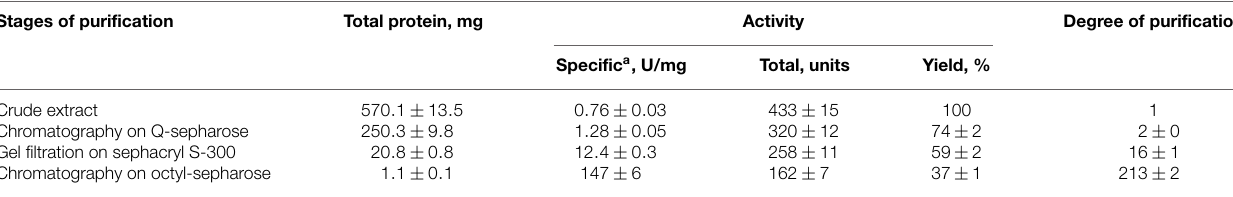
TABLE 2 | The purification of EnoCa . Stages of